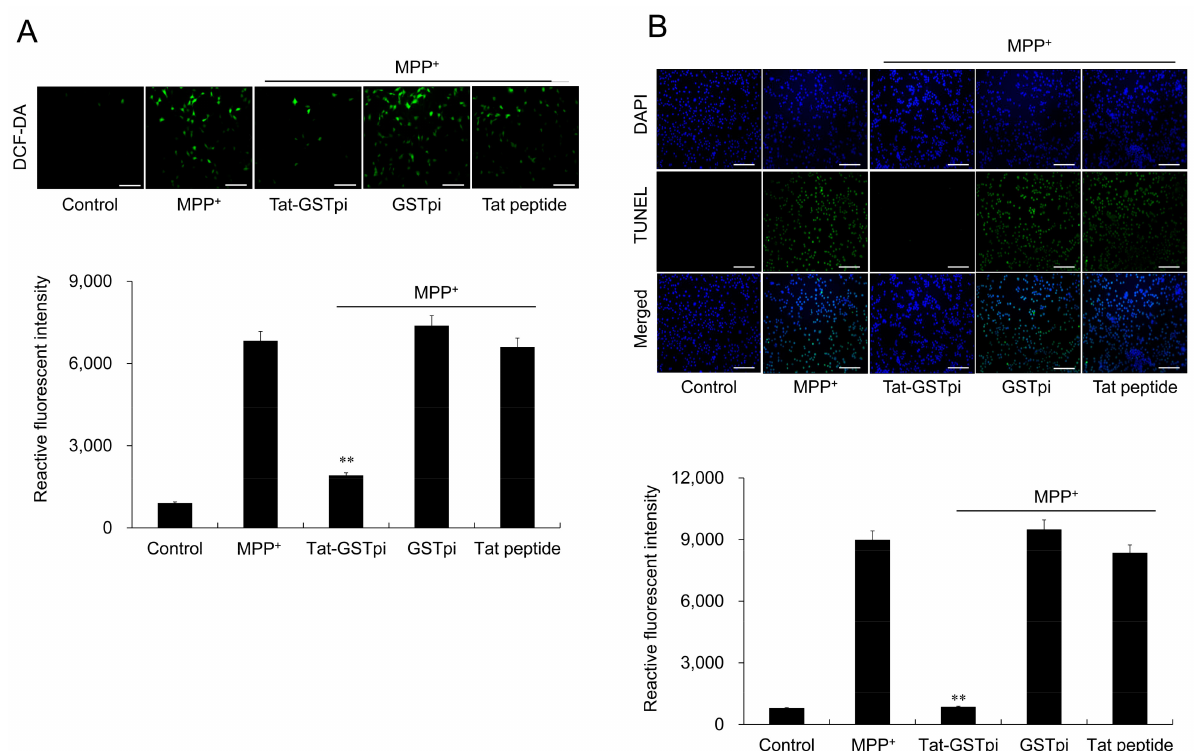
Figure 4. Effect of Tat-GSTpi protein on MPP + -induced cytotoxicity in the SH-SY5Y cells. ( A ) Cells were treated with Tat-GSTpi (3 µ M), GSTpi protein, and Tat peptide for 1 h and exposed to MPP + (5 mM) for 30 min. Intracellular ROS levels were determined by DCF-DA staining; ( B ) Cells were treated with Tat-GSTpi (3 µ M), GSTpi protein, and Tat peptide for 1 h and exposed to MPP + (5 mM) for 13 h. DNA fragmentation was detected by TUNEL staining. Fluorescence intensity was quantified using an ELISA plate reader. Data are represented as mean ± SEM ( n = 3). Scale bar = 50 µ m. ** p < 0.01, compared with MPP + -treated